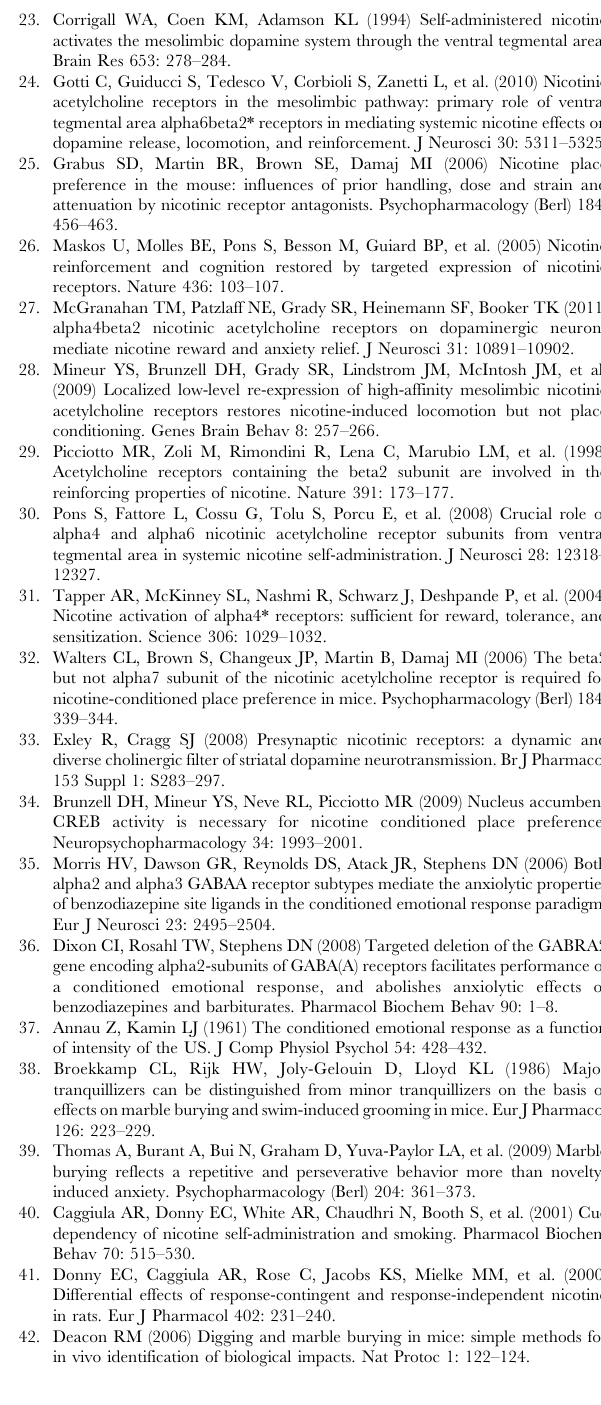
Figure S1 Operant responding during individual ses- sions in absence of drug. Variability in Pre-CS responding was observed in mice exposed to both 0.1 and 0.3 mA footshock unconditioned stimulus (US) over within-subject delivery of both nicotine and DH b E. The timing of the conditioned stimulus (CS) may have contributed to this variability, as operant responding fluctuated within individual